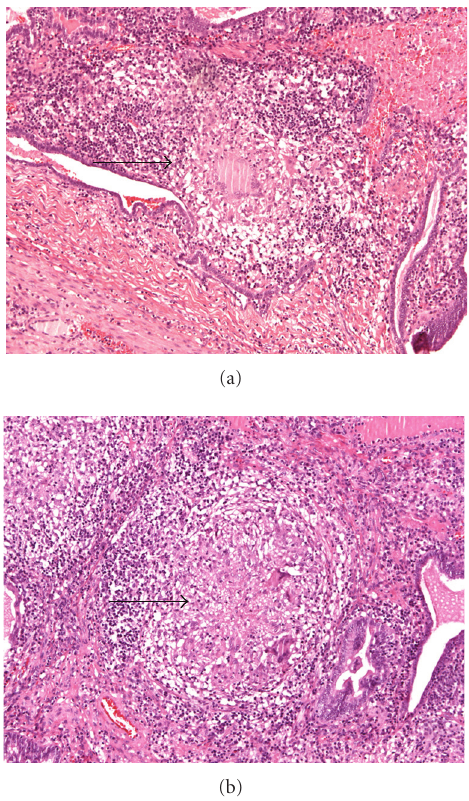
Figure 1: Ultrasound findings. On ultrasound examination a 5 × 6cm cystic mass lesion in the area of the left fallopian tube could be displayed.